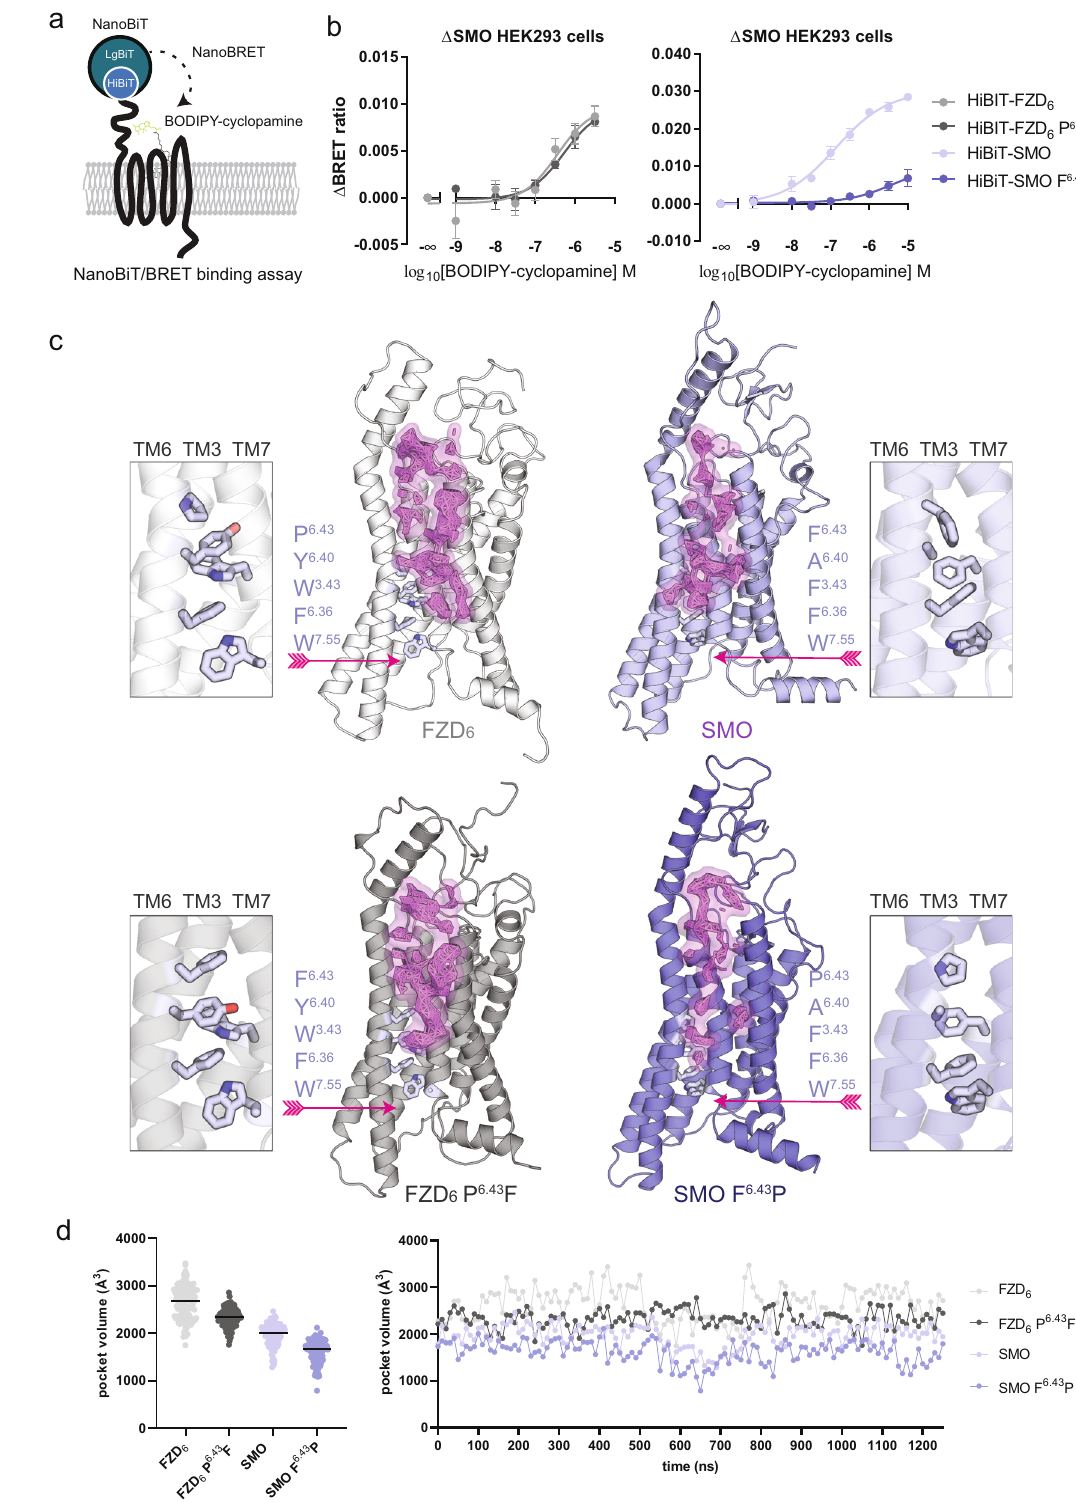
currently available are FZD 4 and FZD 5 (both in the ligand-free apo form; PDB IDs: 6BD4 and 6WW2, respectively; 30,31 ), where the same interactions are observed — F 6.36 is facing towards W